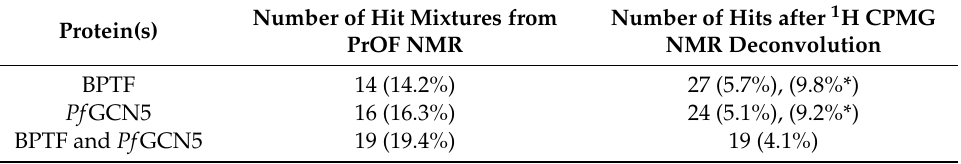
Table 1. Hit rate for both steps of the screening